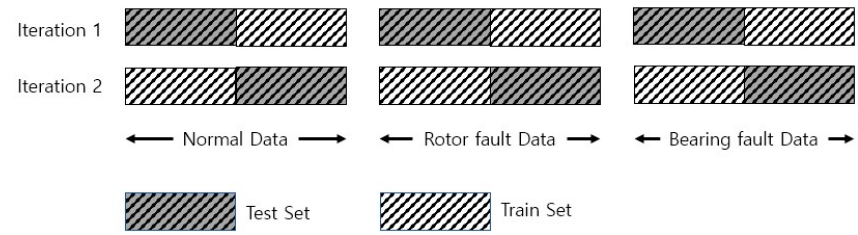
Figure 10. Stratified two-fold cross-validation method.